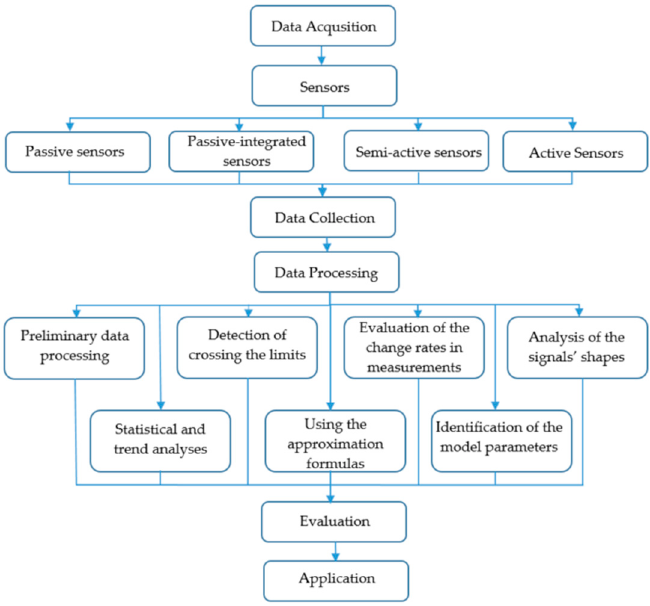
Figure 6. Possible use of the data processing method .